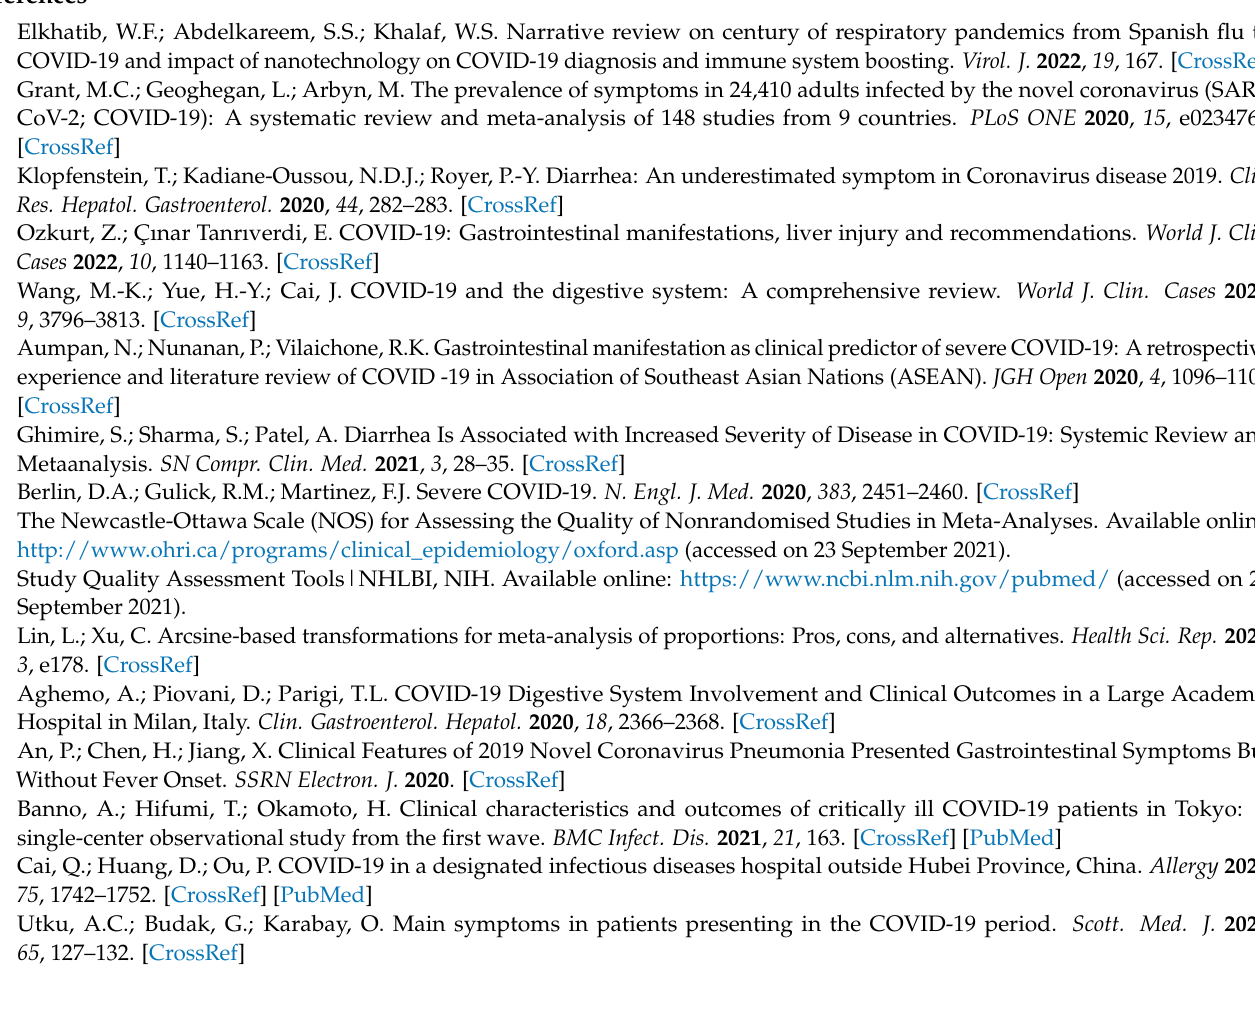
non-Asian groups: title; Table S1: Newcastle–Ottawa scale (NOS) summary assessment of the risk of bias in 16 cohort studies; Table S2: Newcastle–Ottawa scale (NOS) summary assessment of the risk of bias in 2 case-control studies; Table S3: Newcastle-Ottawa scale (NOS) summary assessment of the risk of bias for a cross-sectional study; Table S4: National Institutes of Health (NIH) study quality assessment tool for risk of bias for case-series